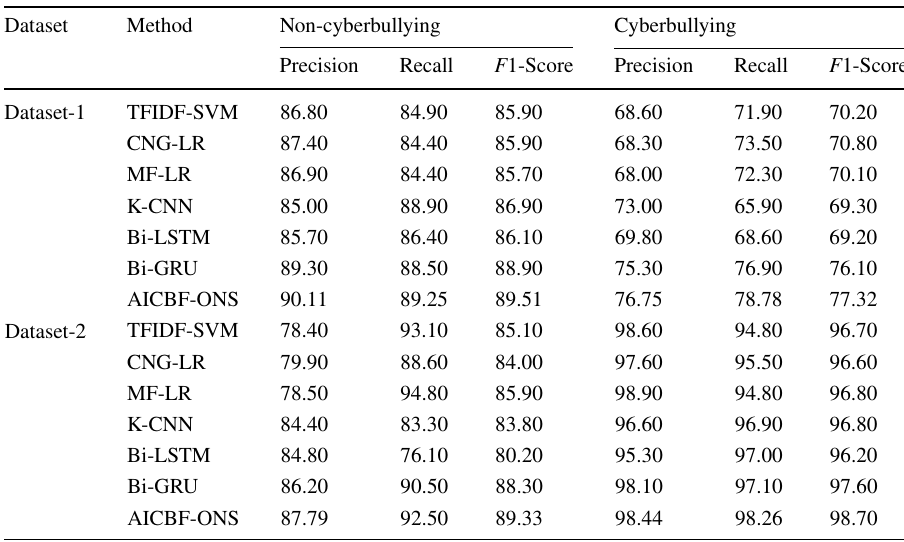
Table 2 Results analysis of existing with proposed method in terms of each class